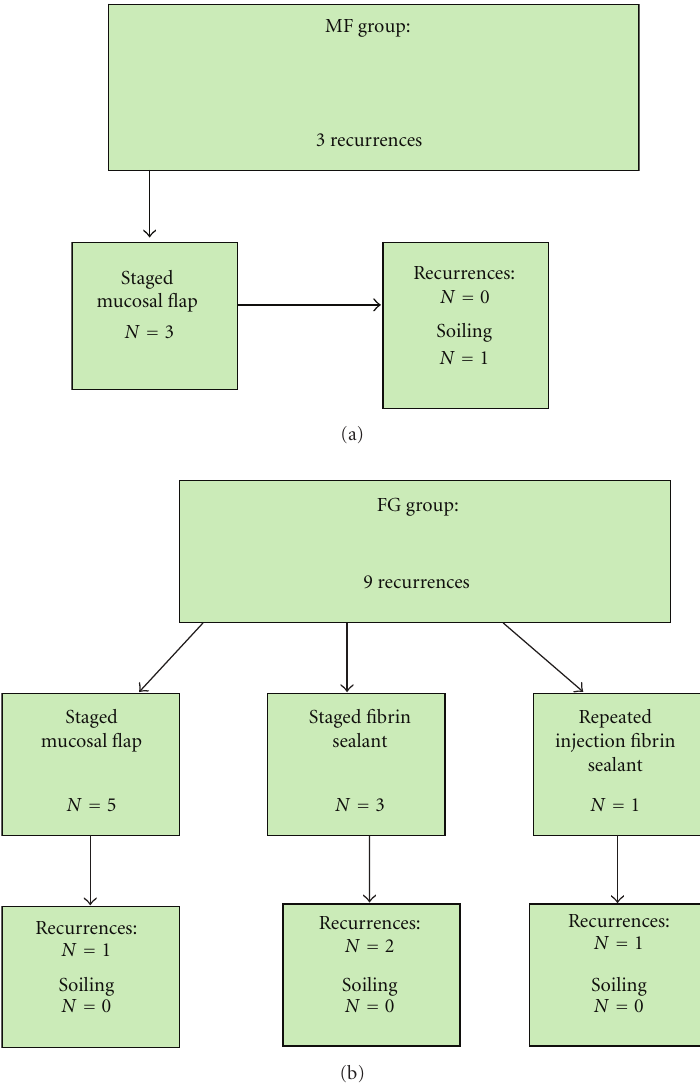
Figure 2: (a) Treatment of patients with recurrent fistulas after MF. (b) Treatment of patients with recurrent fistulas after